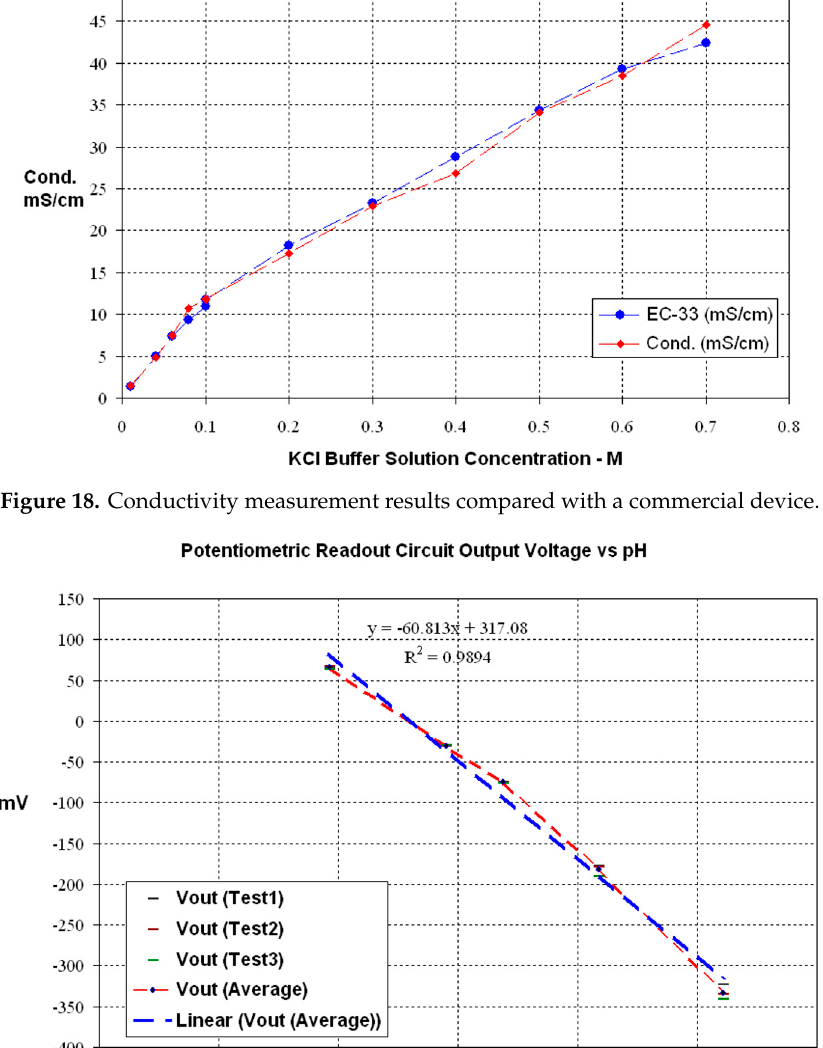
Figure 19. Potentiometric circuit output voltage vs. pH.